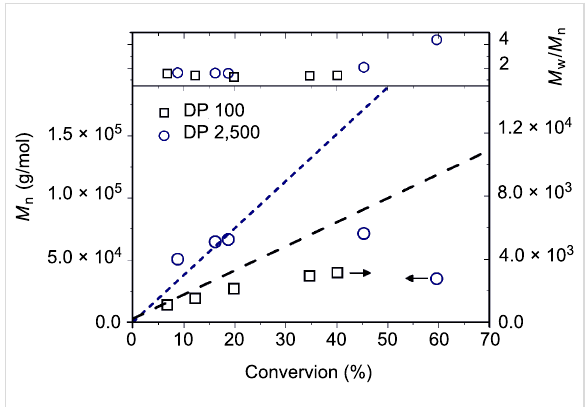
Figure 1: Evolution of number-average molecular weight ( M n ) and M w / M n values of the poly(VBC) chains obtained by RAFT polymeriza- tion with PABTC as CTA and thermal autoinitiation. Dashed lines depict the theoretical molecular weights obtained from Equation 1 without taking into account the thermally initiated